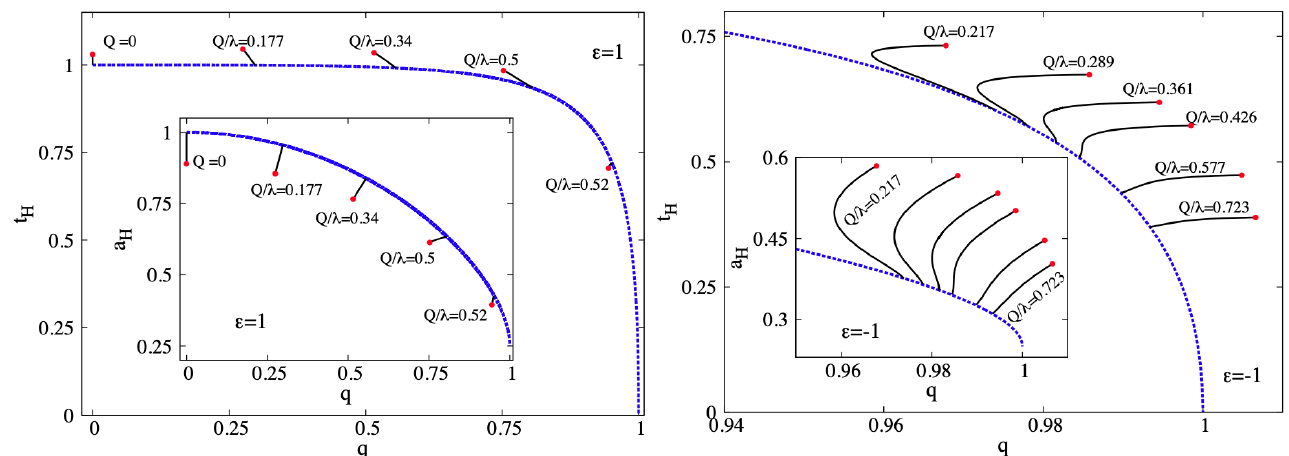
Figure 3. Charge-temperature (main panels panel) and charge-horizon area (insets) diagrams, in units set by mass, for several illustrative families of GB (cid:101) scalarised RN solutions, for both (cid:101) = + 1 ( left panel ) and (cid:101) = − 1 ( right panel ). The branches of scalarised solutions bifurcate from the electrovacuum RN BHs (blue line) and terminate in critical configurations (red